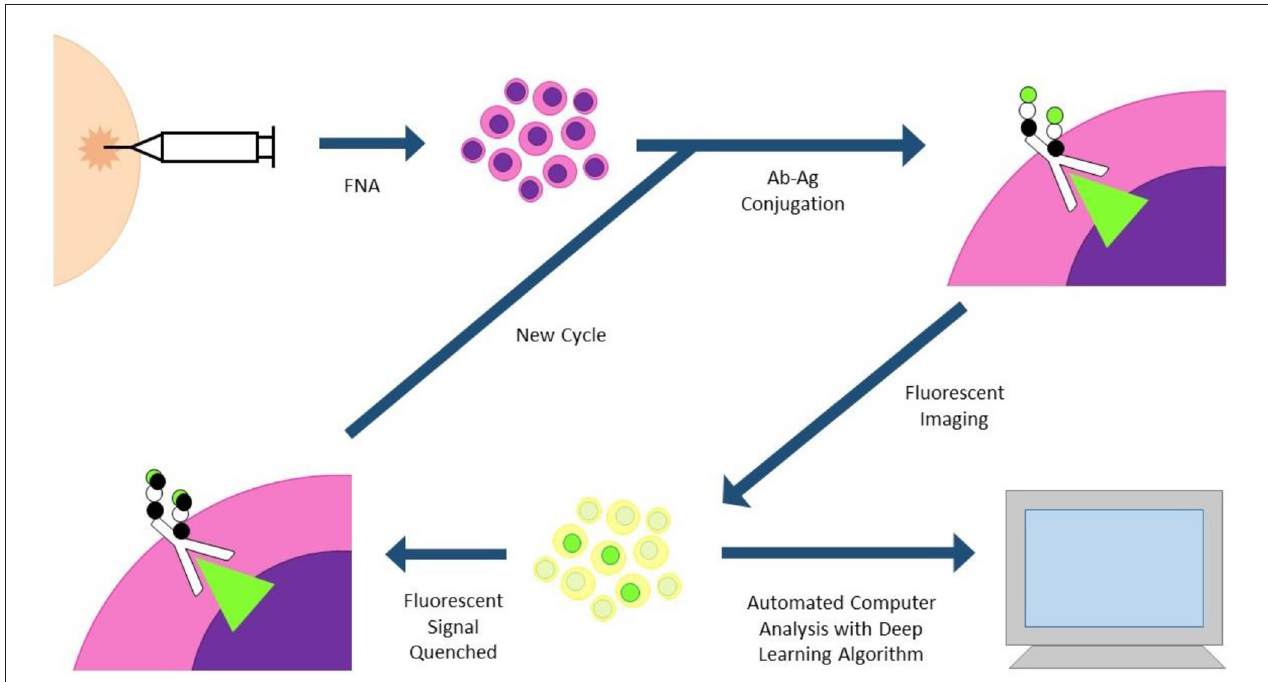
FIGURE 3 | FAST-FNA (fast analytical screening technique fine needle aspiration). FNA biopsy samples are fixed and stained with fluorescent-labeled antibodies. Antibodies are conjugated to trans-cyclooctene (TCO), conjugated to tetrazine (Tz), conjugated to a fluorescent label. Images are processed in an automated image cytometer; deep learning algorithms quantify marker expression. Tz-activated black hole quenchers quench the fluorescent signal in mere seconds, allowing much shorter time intervals between cycles.